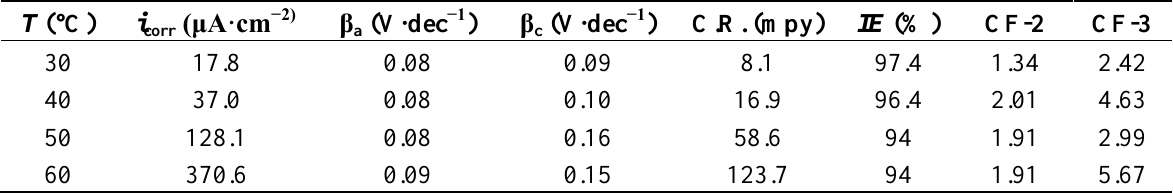
Table 6. EFM parameters for mild steel in 1.0 M HCl with 0.5 mM PMBH at various